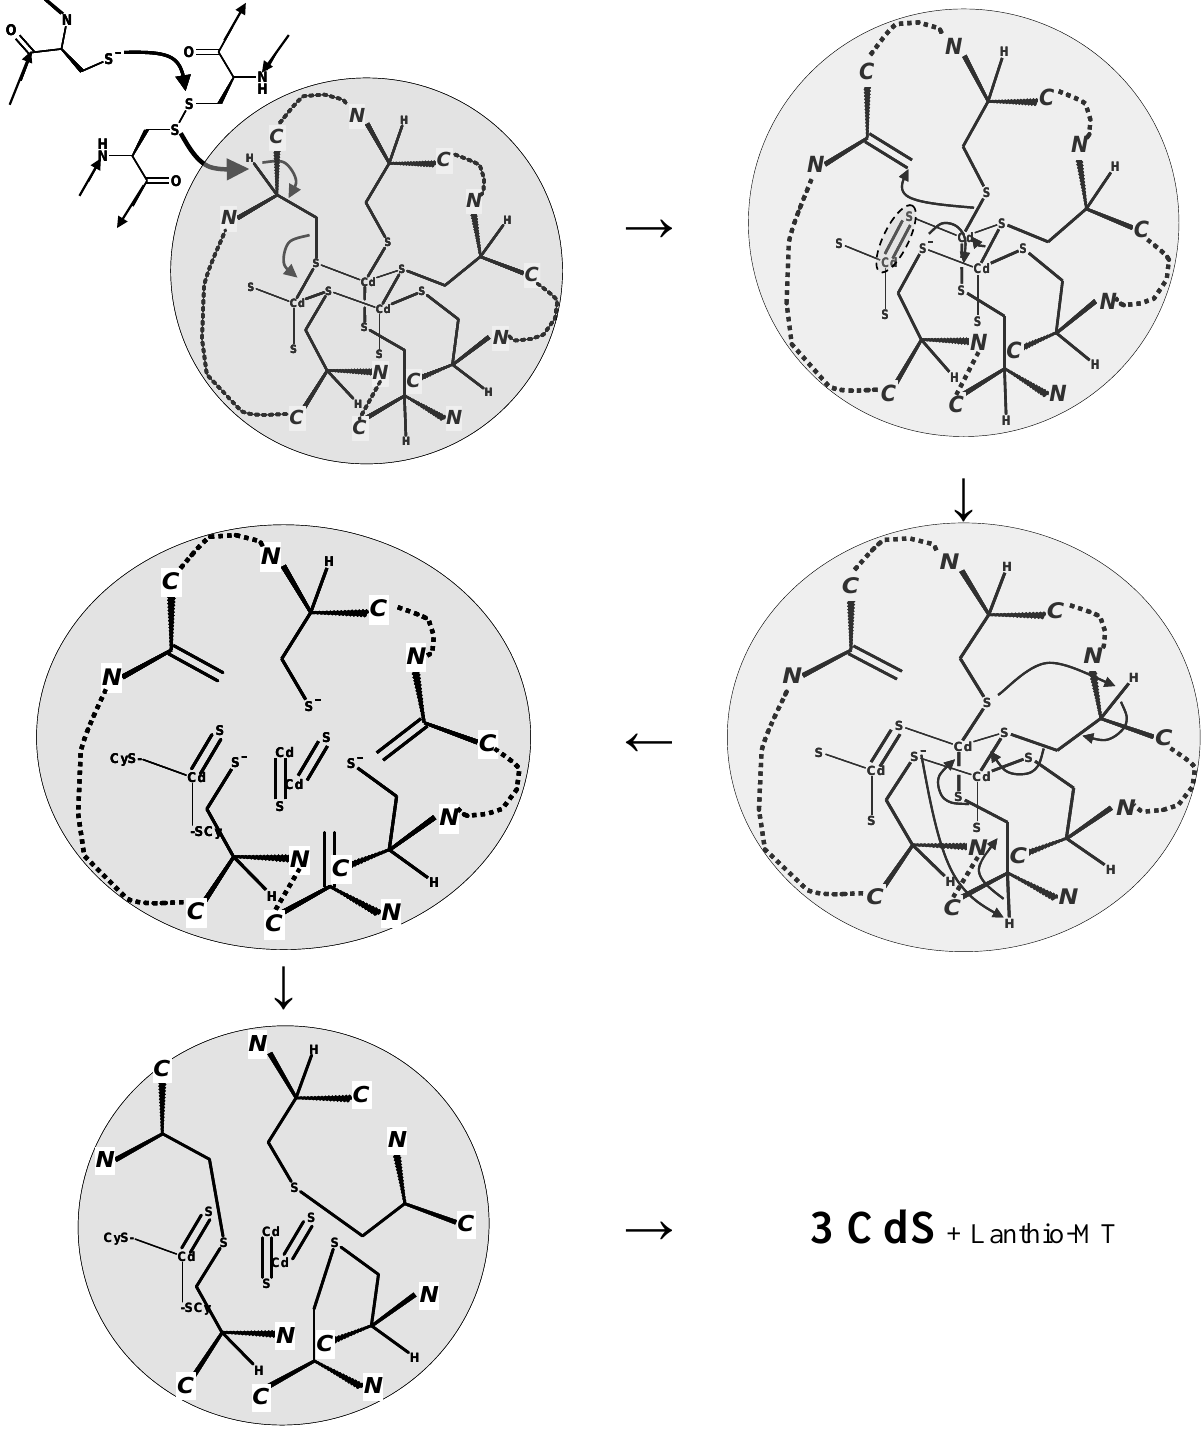
Scheme 14. Generation of cadmium sulphide units from the Cd 3 S 9 unit (Cluster B) of